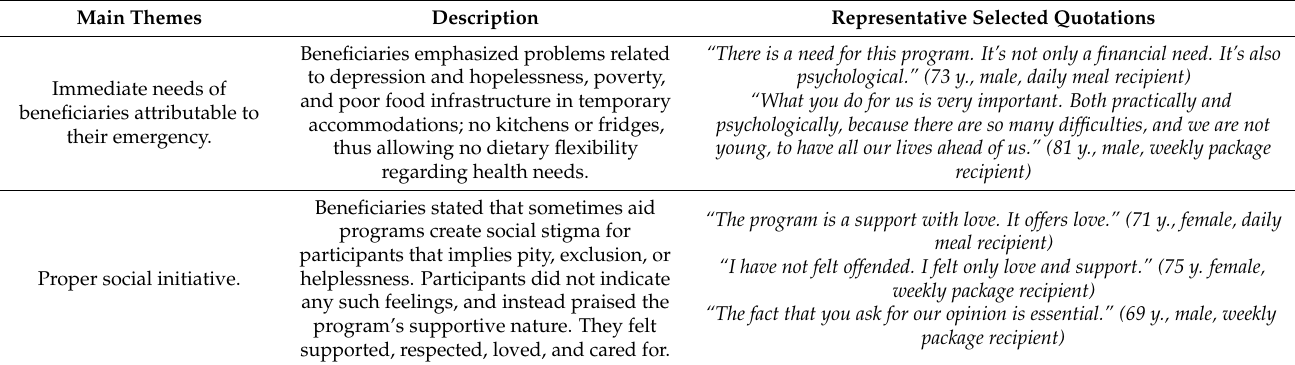
Table 4. Qualitative findings, taken from combining focus groups and personal interview findings, assessing the beneficiaries’ perceptions of the program implementation and effectiveness.